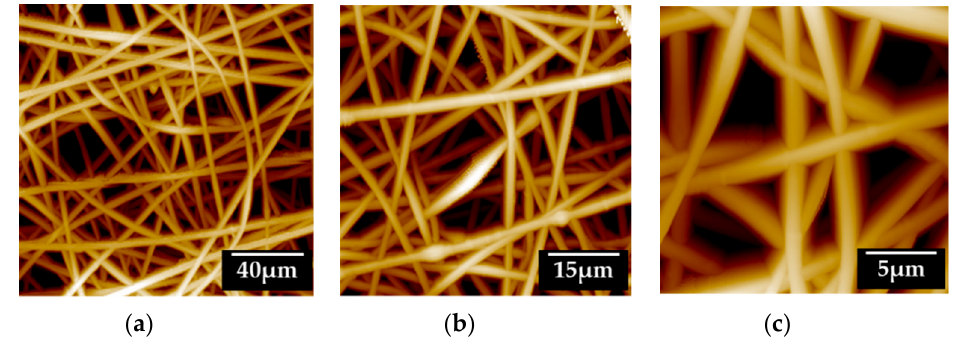
Figure 3. Morphological and surface characterization of the 9% ( w/v ) alginate/CMC/PEO nanofiber film. Analyses used the noncontact mode of atomic microscopy. ( a ), ( b ), and ( c ) are the same films at different scales (scale bars 40 µm, 15 µm, and 5 µm).